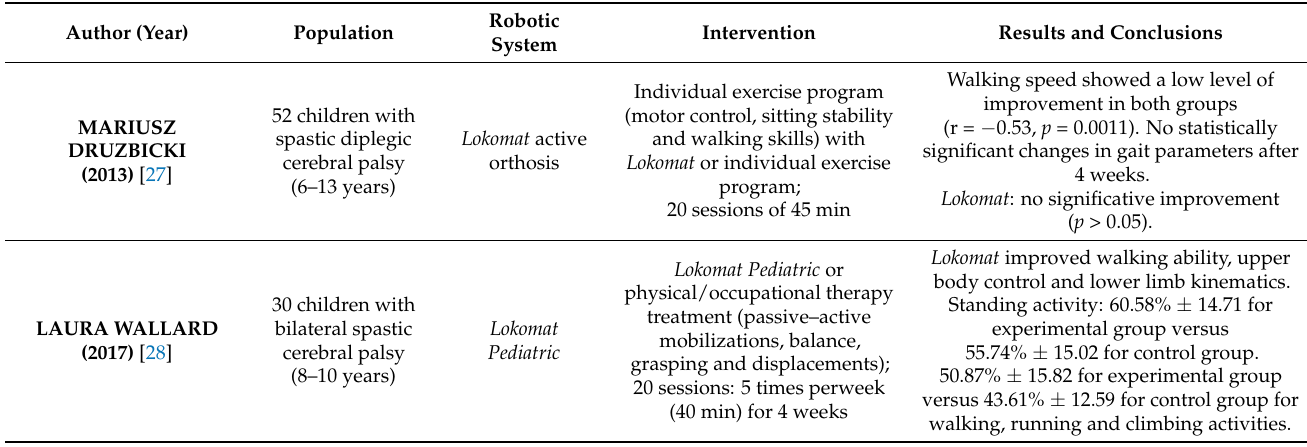
Table 1. Characteristics of the selected articles.